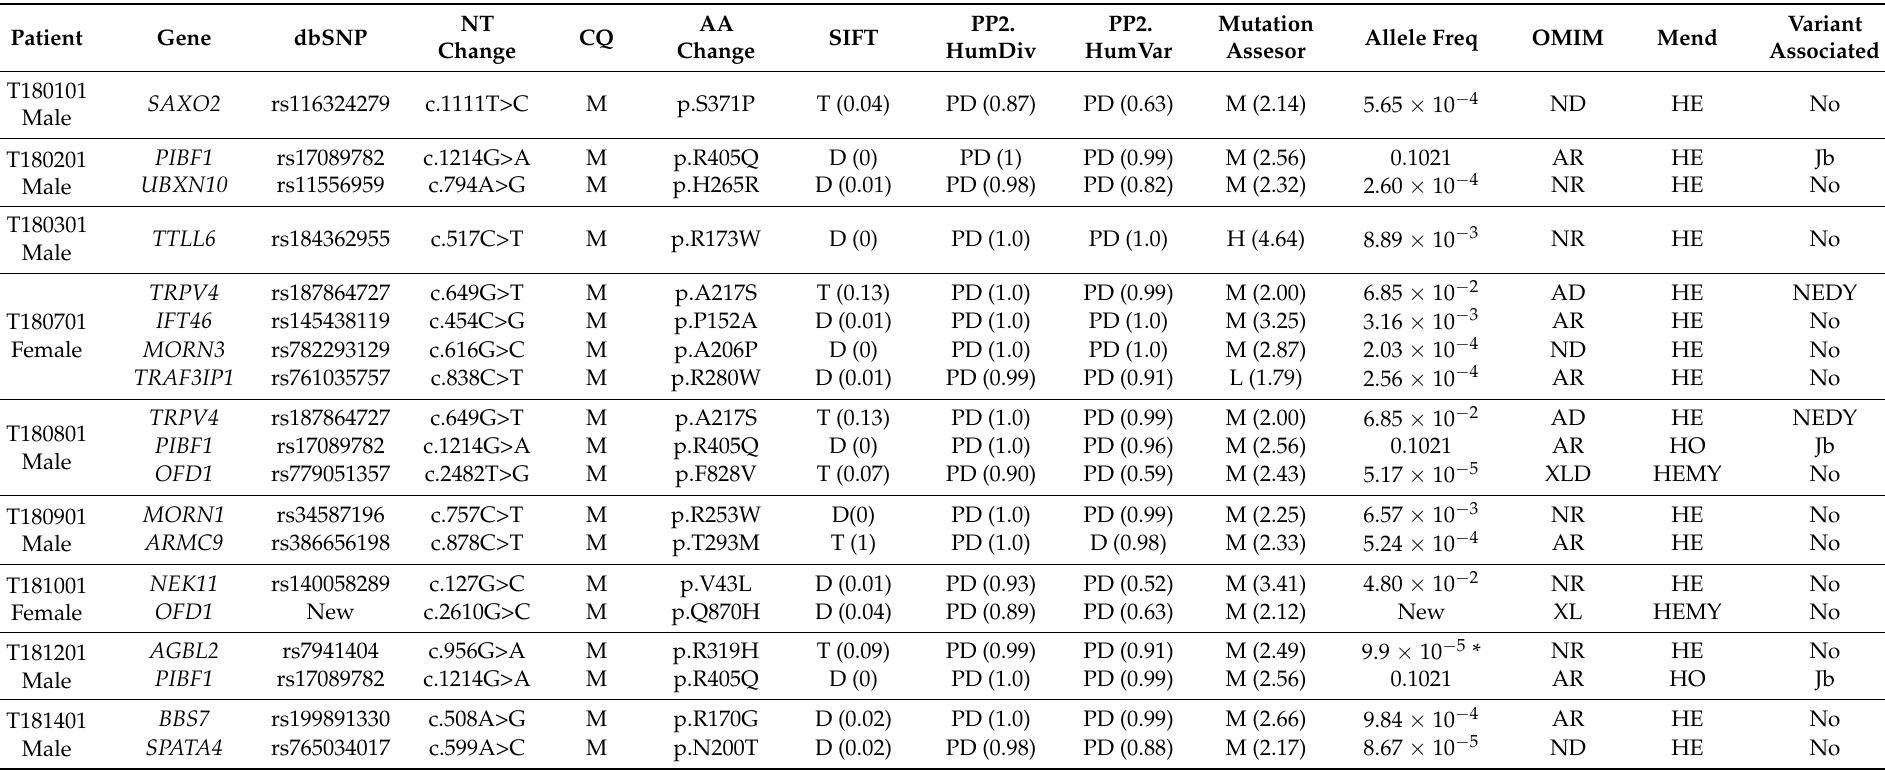
Table 4. Genetic anomalies in ciliogenesis and ciliary trafficking in TGA patients. Missense, splicing, and nonsense anomalies of ciliary genes found in patients with transposition of the great